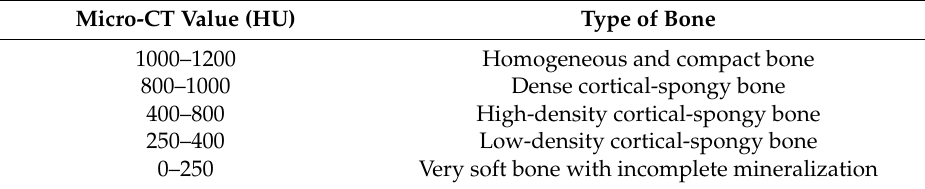
Table 2. Norton [32] classification based on the micro-CT scan determinations of bone